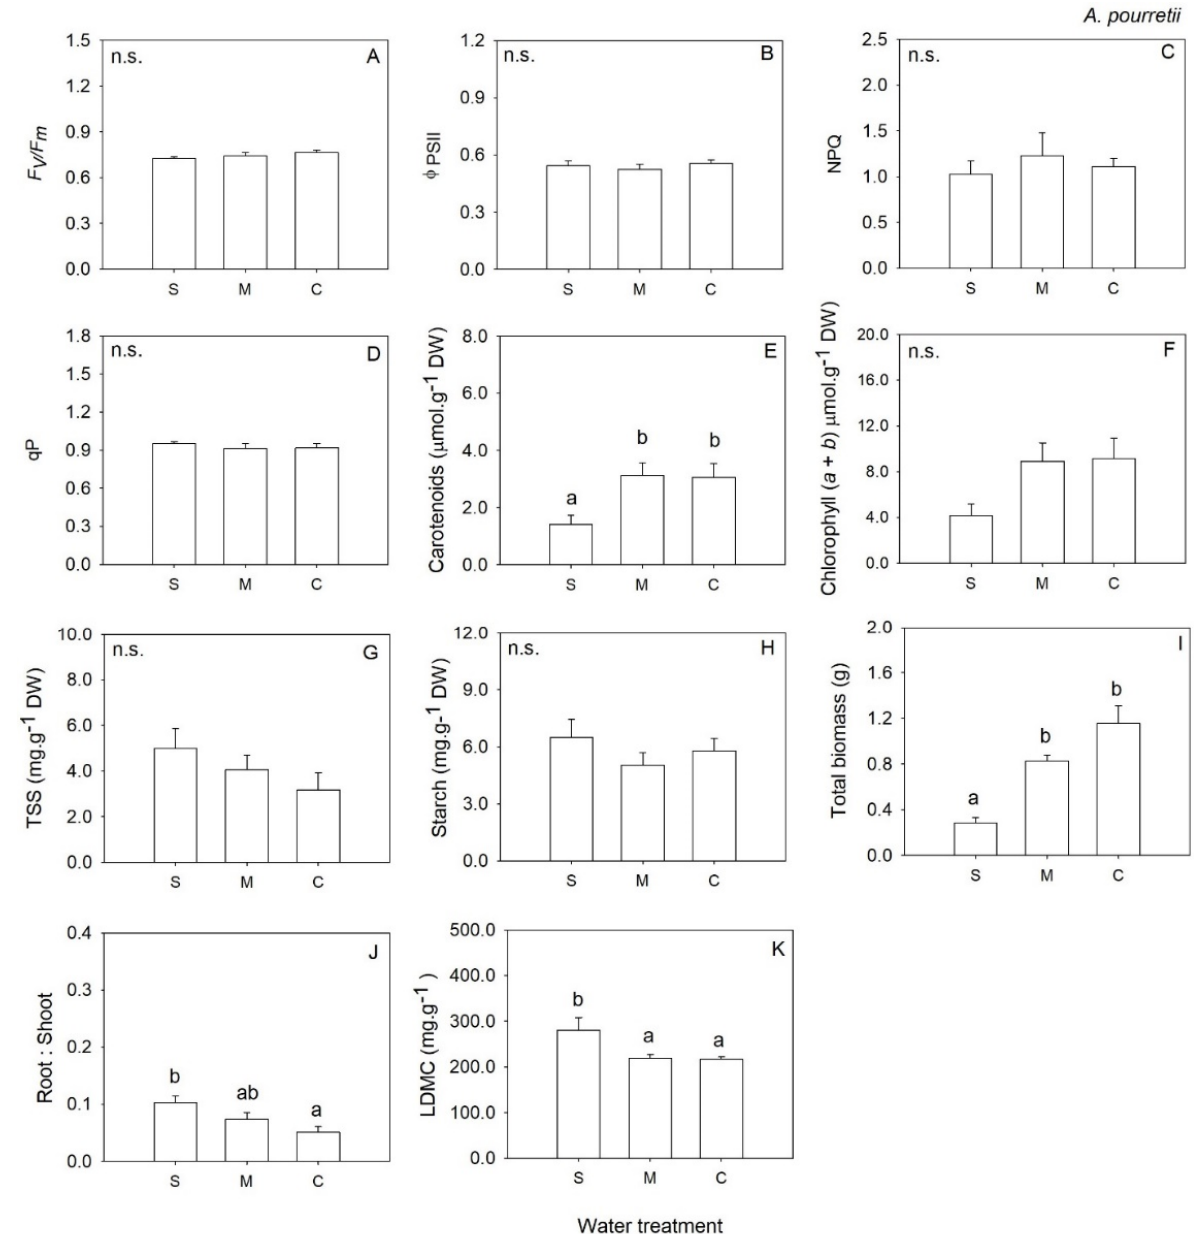
Figure 2. Mean values (+SE) of maximum quantum efficiency of photosystem II ( A ), the effective quantum efficiency of PSII ( B ), non-photochemical quenching ( C ), photochemical quenching ( D ), carotenoids content ( E ), chlorophylls ( a + b ) ( F ), total soluble sugars ( G ), starch content ( H ), total biomass ( I ), root to shoot biomass ratio ( J ) and Leaf Dry Matter Content ( K ) in Agrostis pourretti grown under severe water deficit (S), moderate water deficit (M) and control (C) conditions. Significant differences at p < 0.05 among treatments are indicated by different letters. n.s., not significant. Table 1. Results from the one ‐ way ANOVA testing for the effect of water treatment (severe water deficit, moderate water deficit and control) on the response of morphological and physiological traits measured. Significant p values ( p < 0.05) are highlighted in bold.